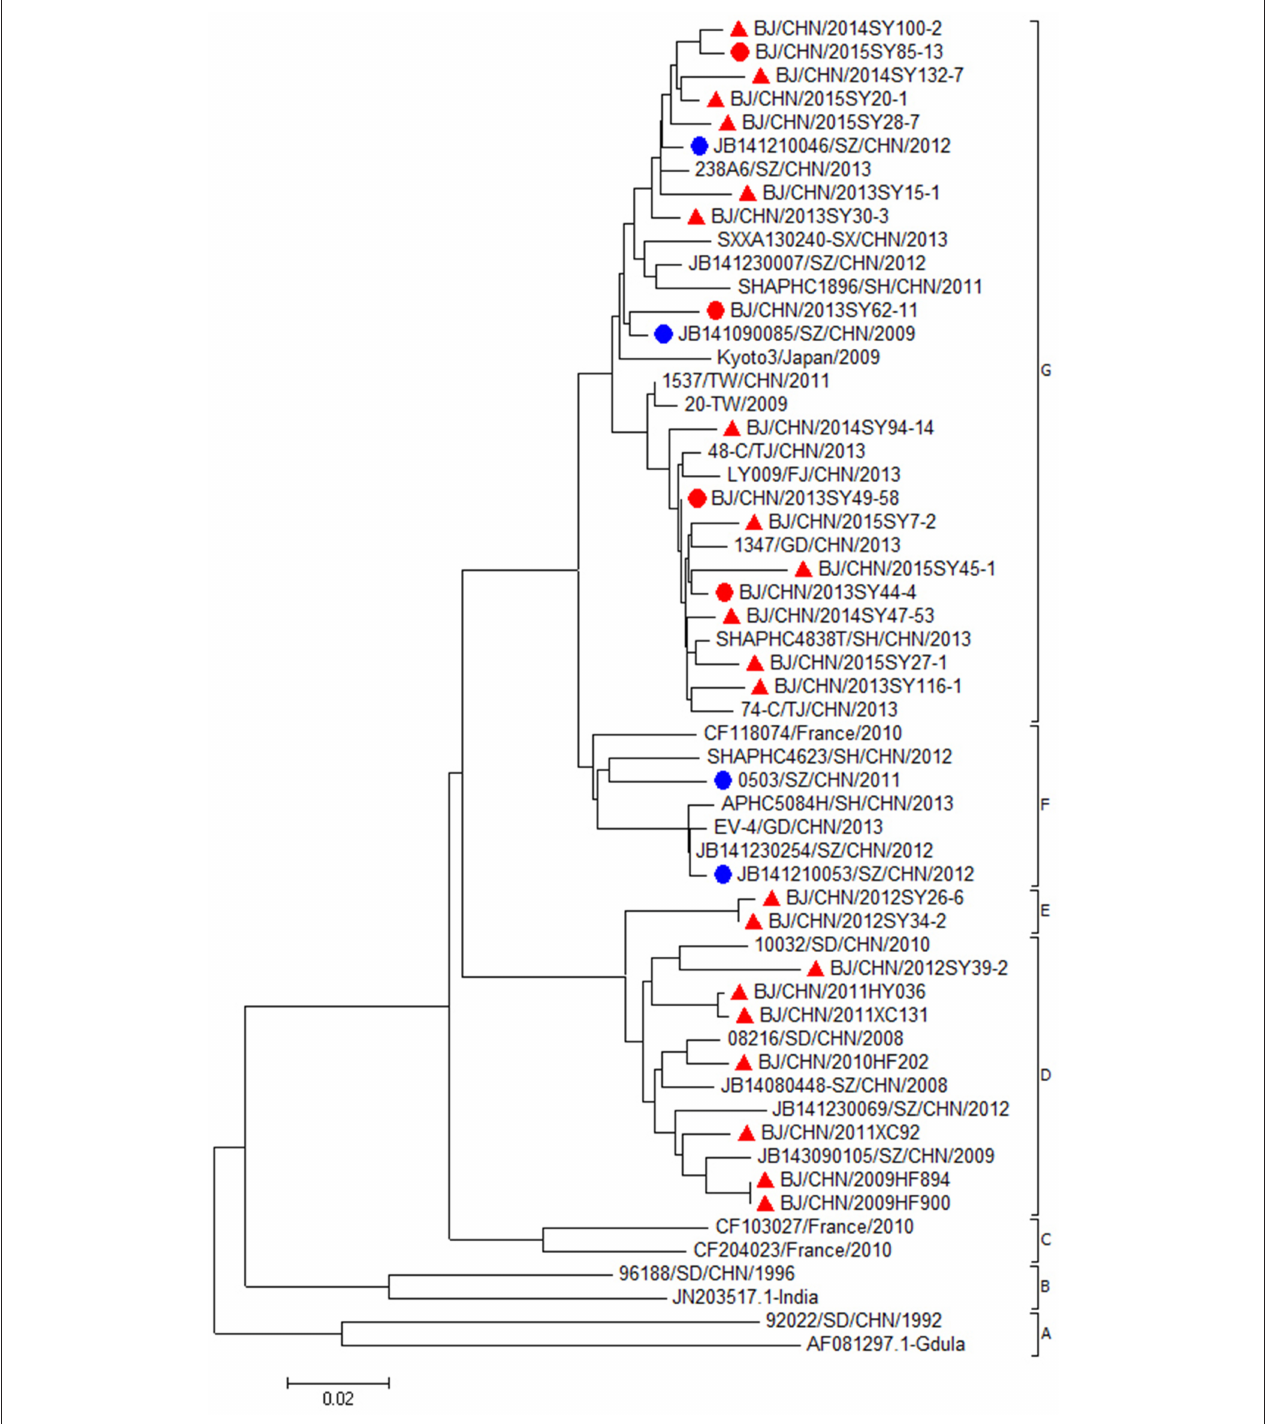
FIGURE 2 | Phylogenetic dendrogram based on the alignment of the complete VP1 gene sequence of CVA6 (915bp). CVA6 strains isolated from mild cases, severe cases in Beijing were indicated by a red triangle, a red dot, respectively. CVA6 strains isolated from severe cases in other cities were indicated by a blue dot.